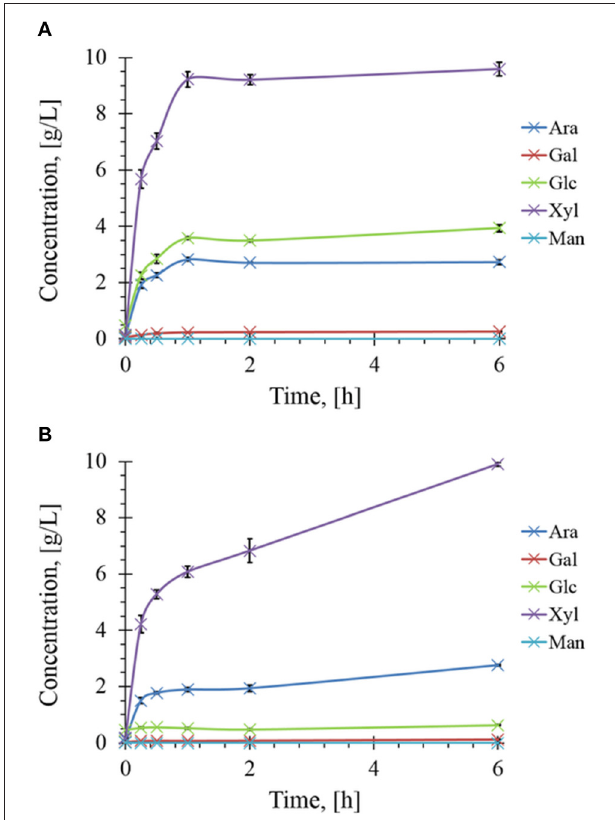
FIGURE 8 | Kinetics of soluble sugars released during enzymatic treatment of the destarched wheat bran Rovabio ® (A) and xylanase C (B) . Operating conditions identical to Figure 2 . The soluble sugars were expressed as equivalent of monosaccharides glucose (Glc), xylose (Xyl), arabinose (Ara), mannose (Man), and galactose (Gal) after their chemical acid hydrolysis as described in Material and